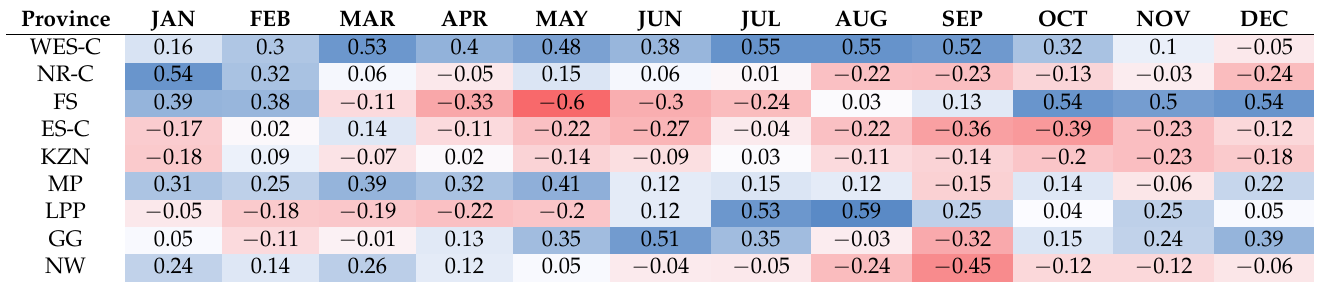
Table 6. Correlation between SYRS and SPI-3 on a monthly time scale and on a regional scale